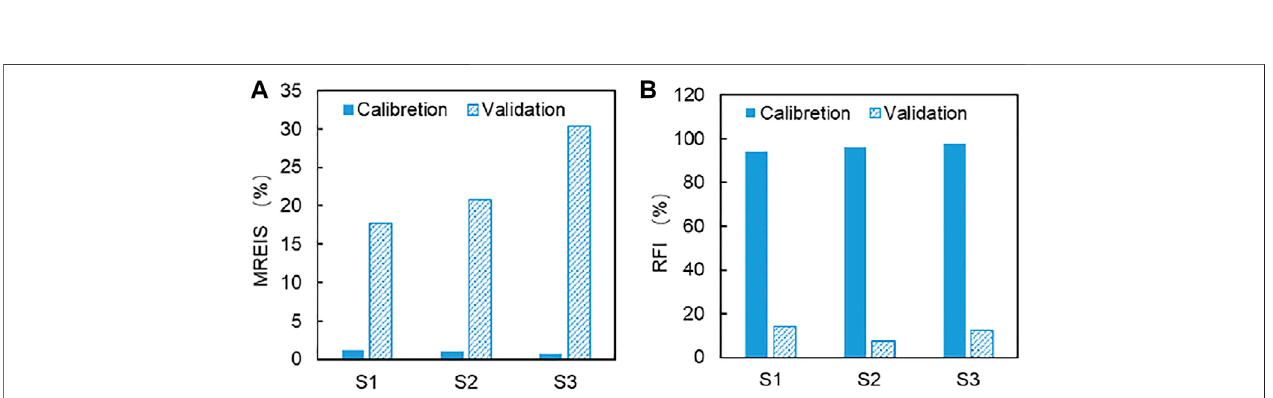
FIGURE8| Theperformance(MREISand RF)ofSCAH forthecalibrationand validationperiods.(Note: S1,S2,andS3representYichangstation, Hankoustation, and Datong station).